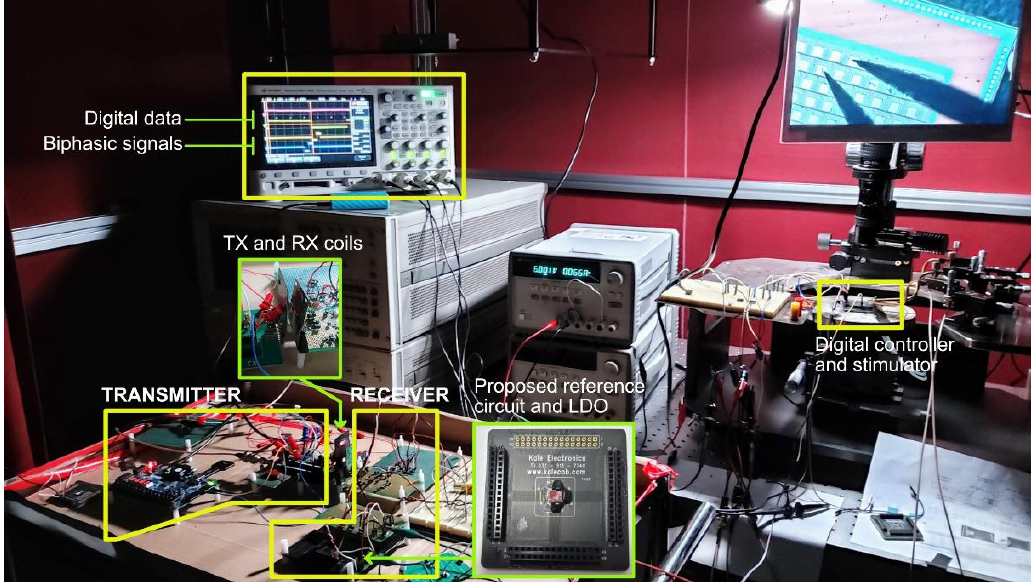
Figure 7. Full-path prosthetic system experimental setup.